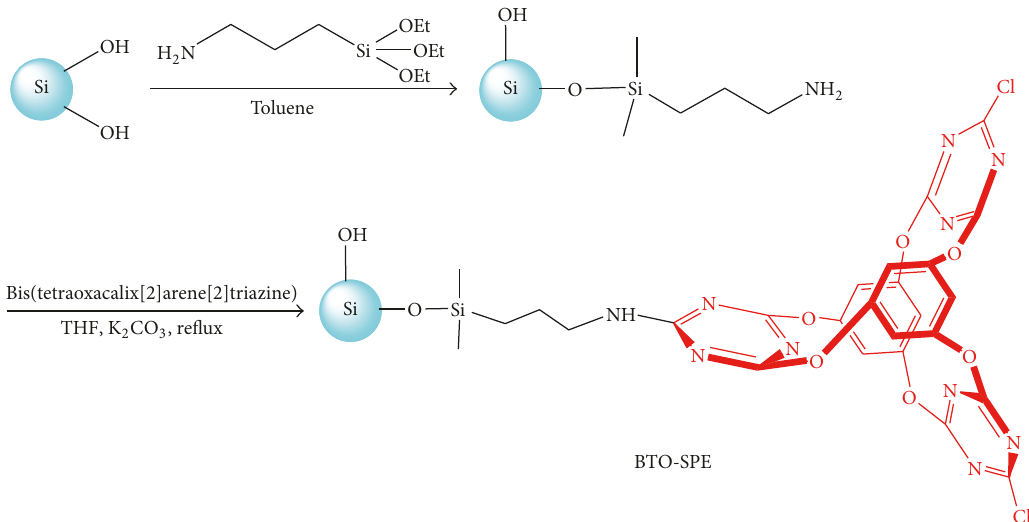
Figure 2: Preparation scheme of bis(tetraoxacalix[2]arene[2]triazine)-modified silica gel SPE sorbent (BTO-SPE).